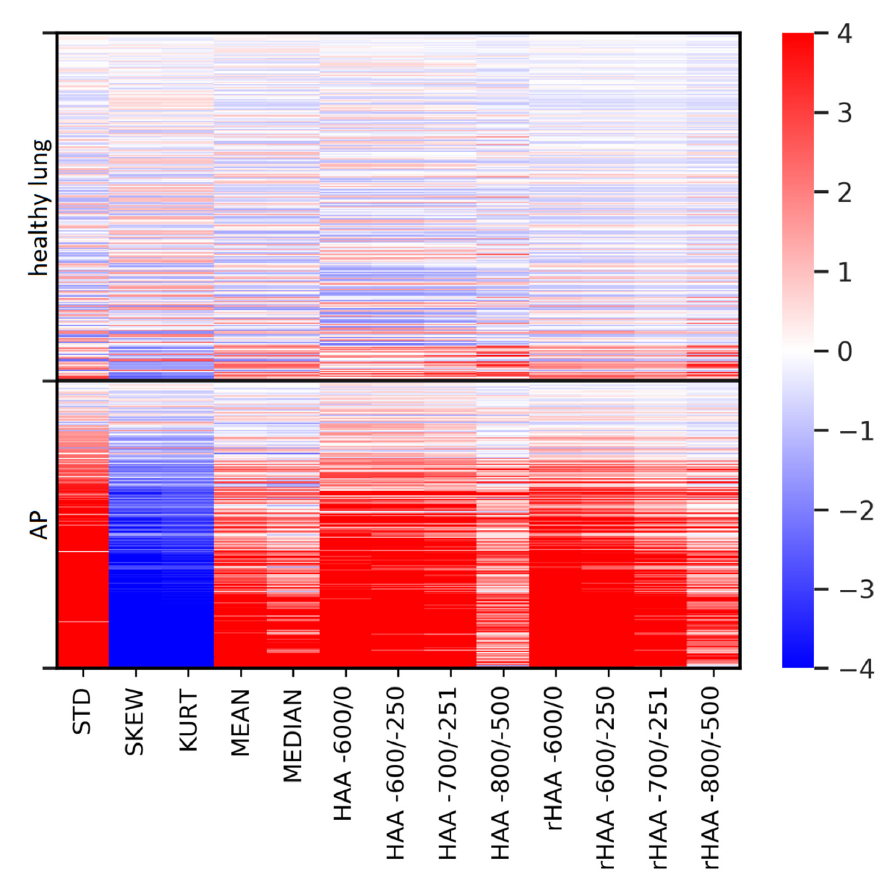
Figure 4. Imaging parameters for differentiation between healthy lungs and AP. An overview of all cases included in the analysis illustrating the differences in imaging biomarkers between the healthy lung group and the AP group. Color intensity represents the deviation of the imaging biomarker from the mean of the “healthy lung” group (in SD). Abbreviations: AP = atypical pneumonia. NECT = non-enhanced computed tomography. STD = histogram standard deviation. SKEW = skewness. KURT = kurtosis. MEAN = mean lung attenuation. MEDIAN = median lung attenuation. HAA = high attenuation area. rHAA = relative high attenuation area. SD = standard deviation.